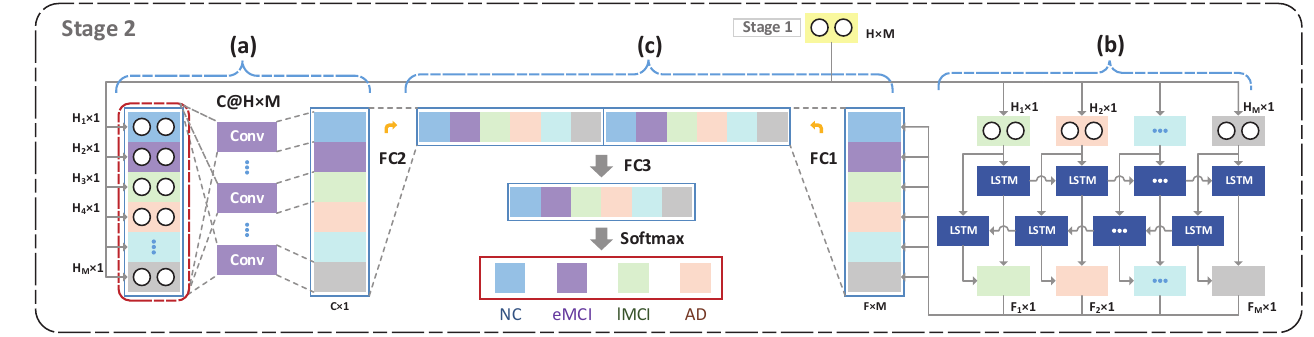
Figure 2. The main processes of the second stage of LSRNet training: ( a ) convolutional neural network for the global perspective, ( b ) BiLSTM network for the local perspective, ( c ) multi-perspective feature fusion